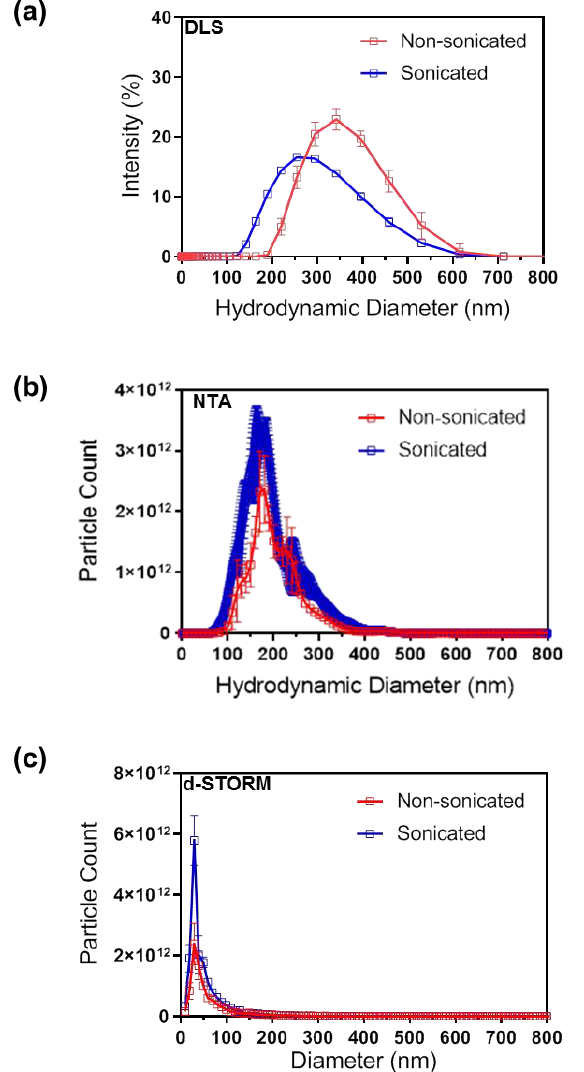
Figure 2. Particle size distribution analysis of non-sonicated and sonicated EVs by ( a ) DLS, ( b ) NTA and ( c ) d-STORM. N = 3, data presented as mean ± SD.